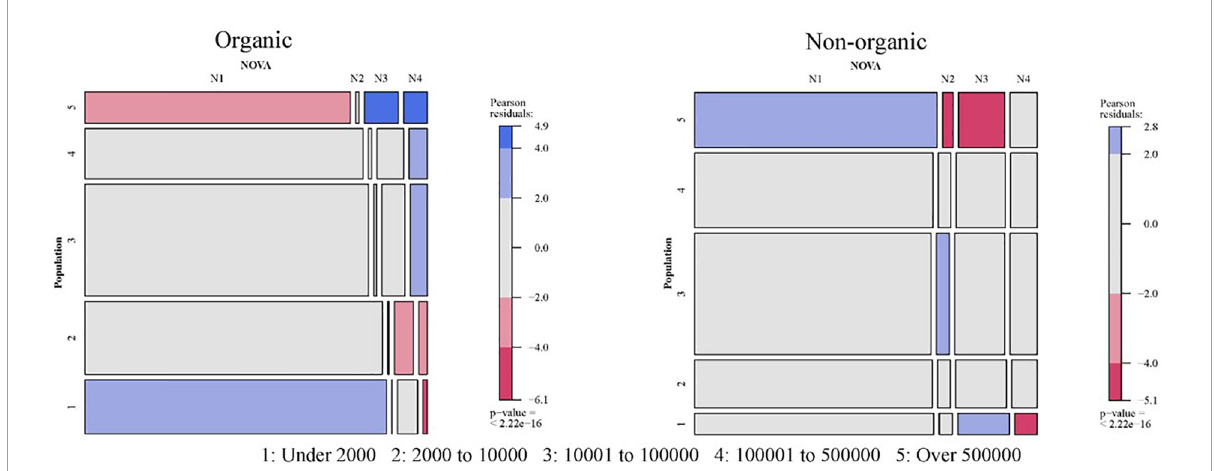
FIGURE4 Relationship between size of the municipality and NOVA: Organic vs. non-organic food purchases. 1: Under 2,000; 2: 2,000–10,000; 3: 10,001–100,000; 4: 100,001–500,000; 5: Over 500,000.